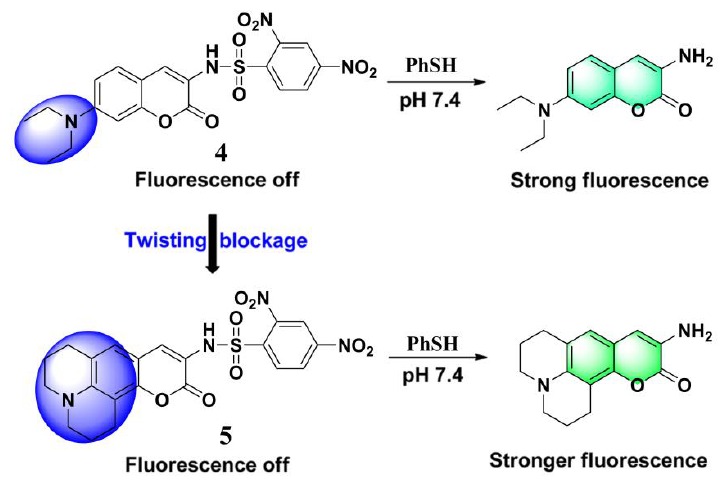
Figure 3. Structures and reactions of probes 4 and 5 with PhSH. Reproduced with permission from